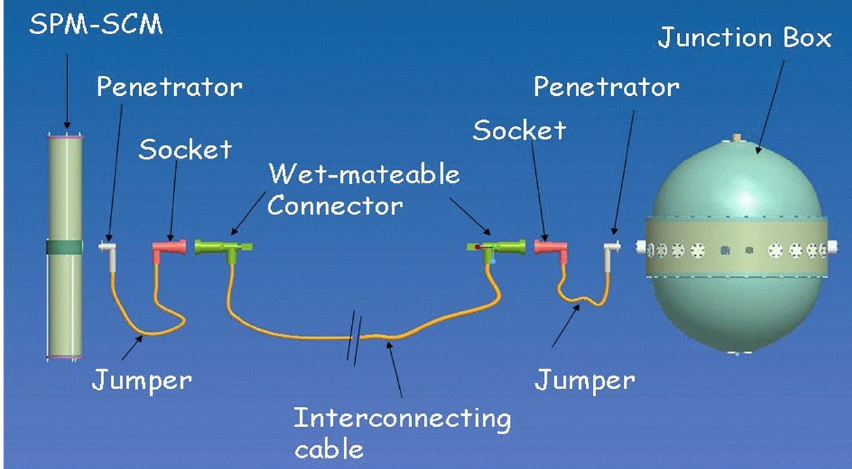
Figure 1. A schematic of the complete link between the string power module/string control module (SPM/SCM) and the junction box in ANTARES [10].